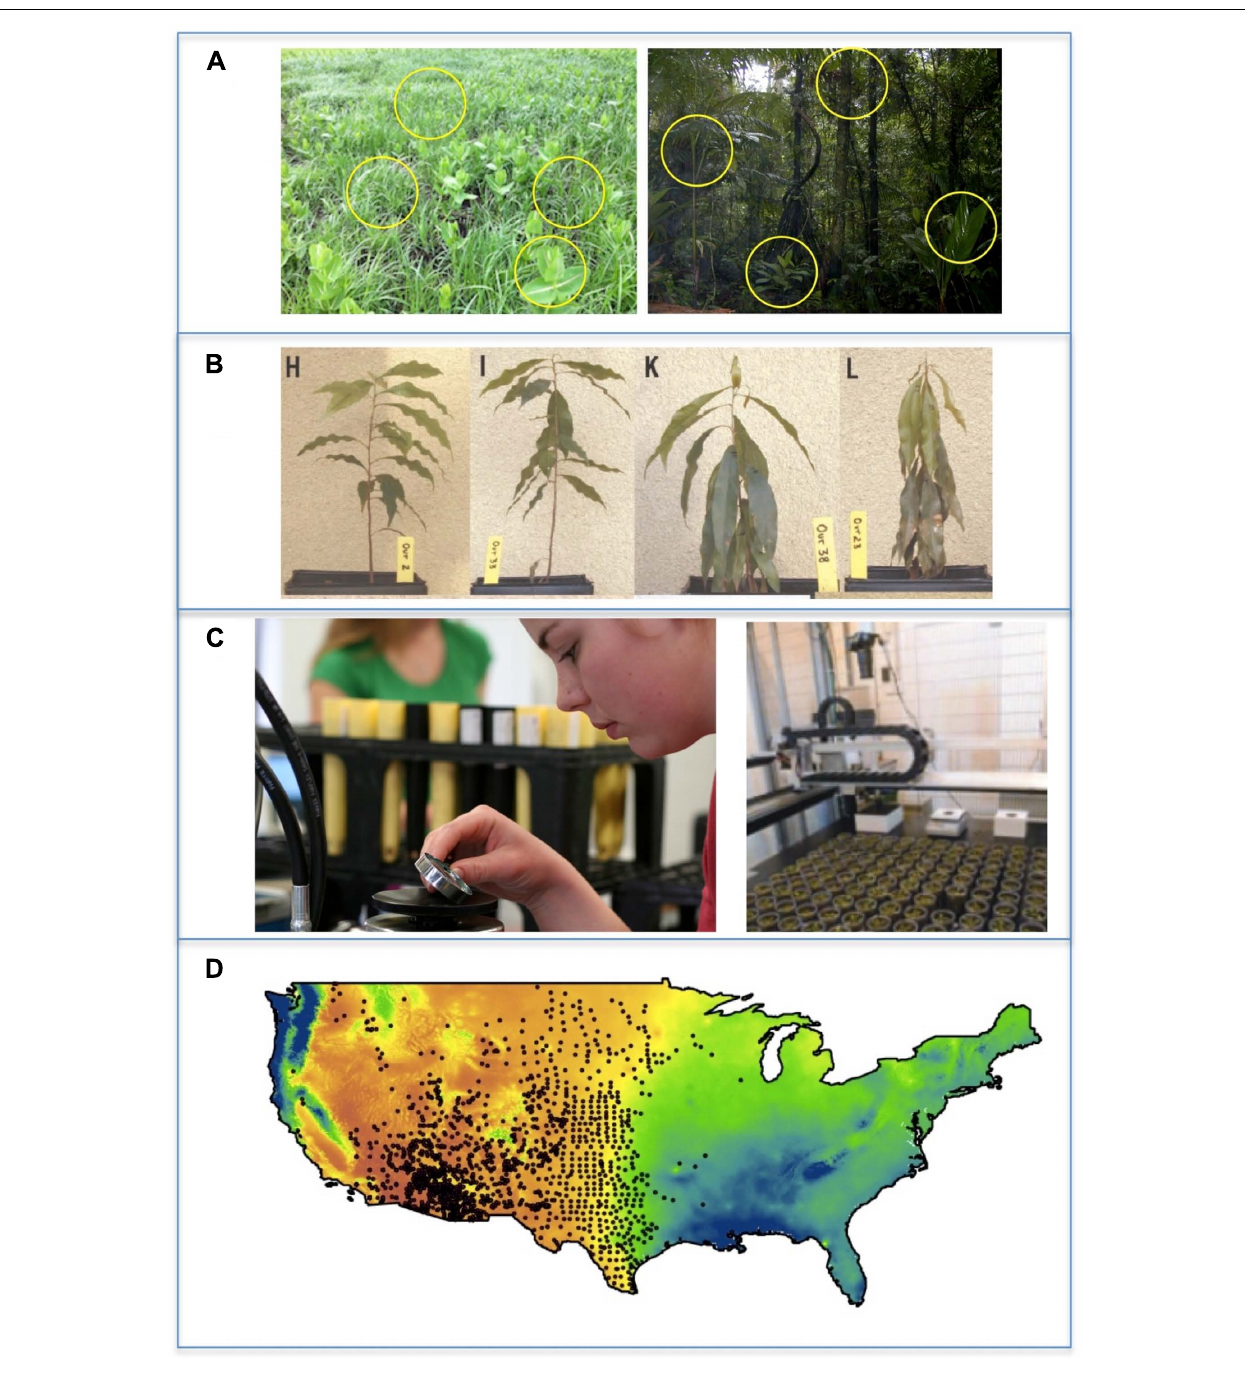
FIGURE 2 |A general overview of the stages of screening species’ low resource tolerance traits for species. (A) All screening efforts begin with species selection. Species are often selected to vary in abundance or in their responses to environmental factors. Species may be selected to represent phylogenetically different lineages or invasiveness. (B) Focal species are grown or sampled under natural or experimental gradients of resource availability. For example, to quantify physiological drought tolerance of tropical trees, plant water potentials were monitored on drying plants until wilting (Engelbrecht etal., 2007). (C) Experiments usually require measuring plant growth, plant resource status, or resource exchange rates to determine the